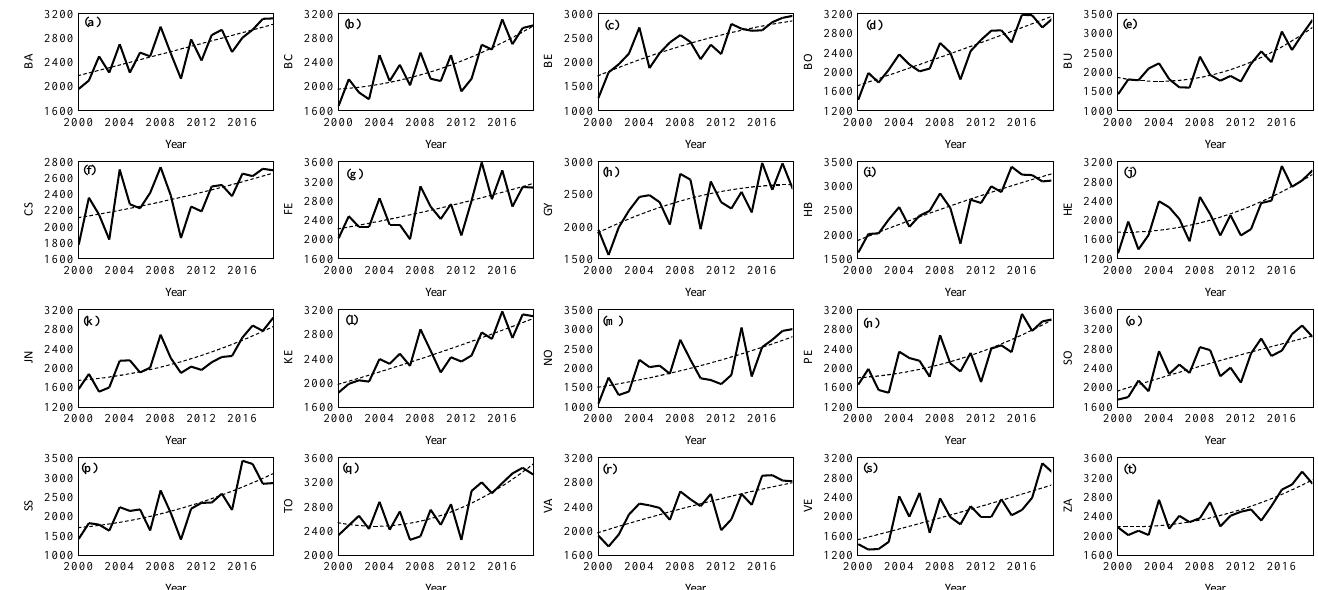
Figure 5. Sunflower yield in the studied Hungarian counties (2000–2019). ( a ) BA, ( b ) BC, ( c ) BE, ( d ) BO, ( e ) BU, ( f ) CS, ( g ) FE, ( h ) GY, ( i ) HB, ( j ) HE, ( k ) JN, ( l ) KE, ( m ) NO, ( n ) PE, ( o ) SO, ( p ) SS, ( q ) TO, ( r ) VA, ( s ) VE, ( t ) ZA. The output of the SSYR analysis highlighted the yeEars 2000, 2010, and 2012 as the years most affected by Ag.D ( SSYR ≤ −1) in terms of sunflower production, as shown in Figure 6. The lowest SSYR was recorded in HB ( − 3.2, extreme impact in 2010), followed by TO ( − 2.41, extreme impact in 2012), and VA ( − 2.34, extreme impact in 2010) (Figure 6).